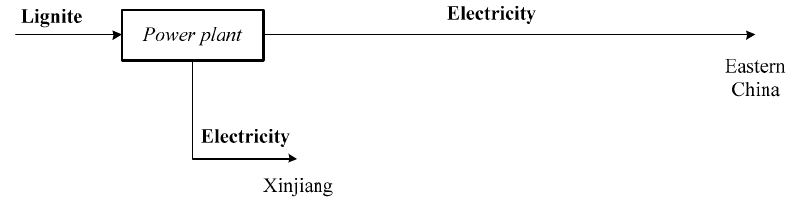
Figure 1. Power generation and transmission system.